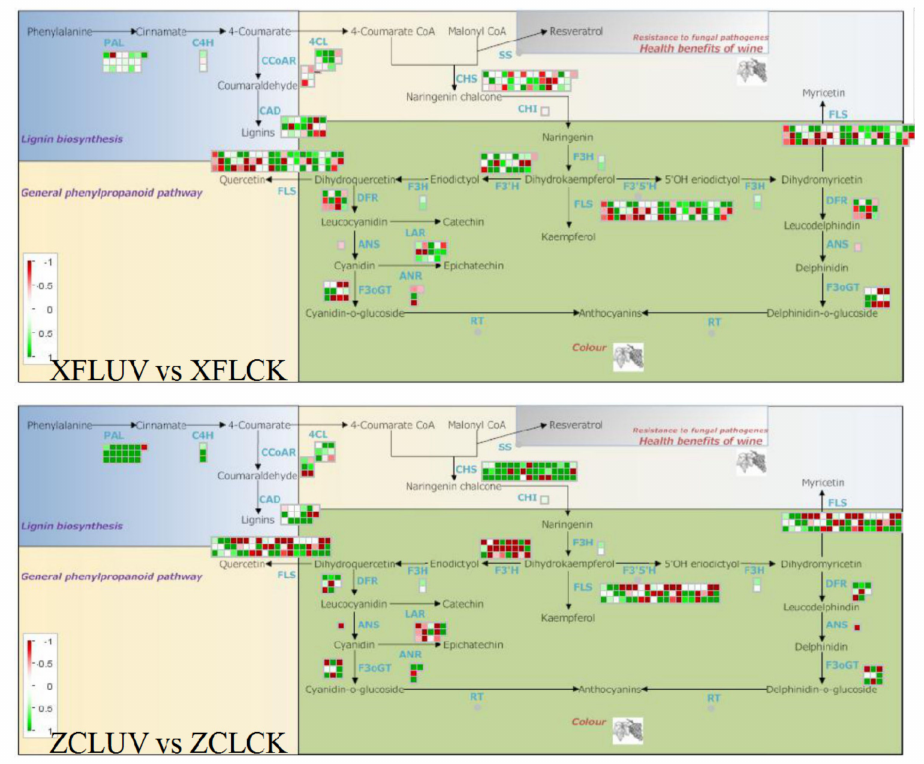
Figure 9. Transcription level of structural genes involved in the general phenylpropanoid pathway based on MapMan. Green represents upregulation, while red represents